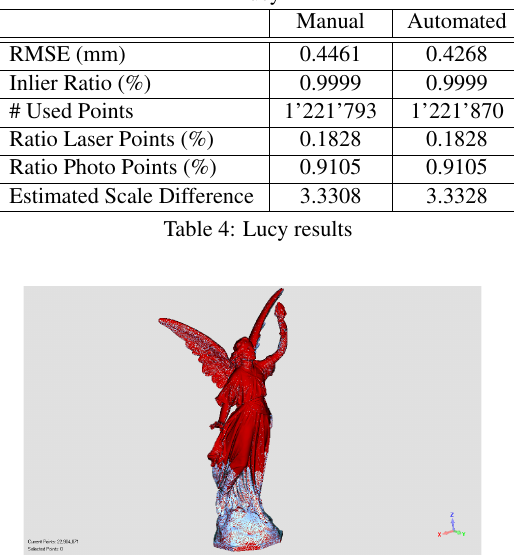
Figure 14: Lucy automatically registered, Red/Dark: Laser, Blue/Light: